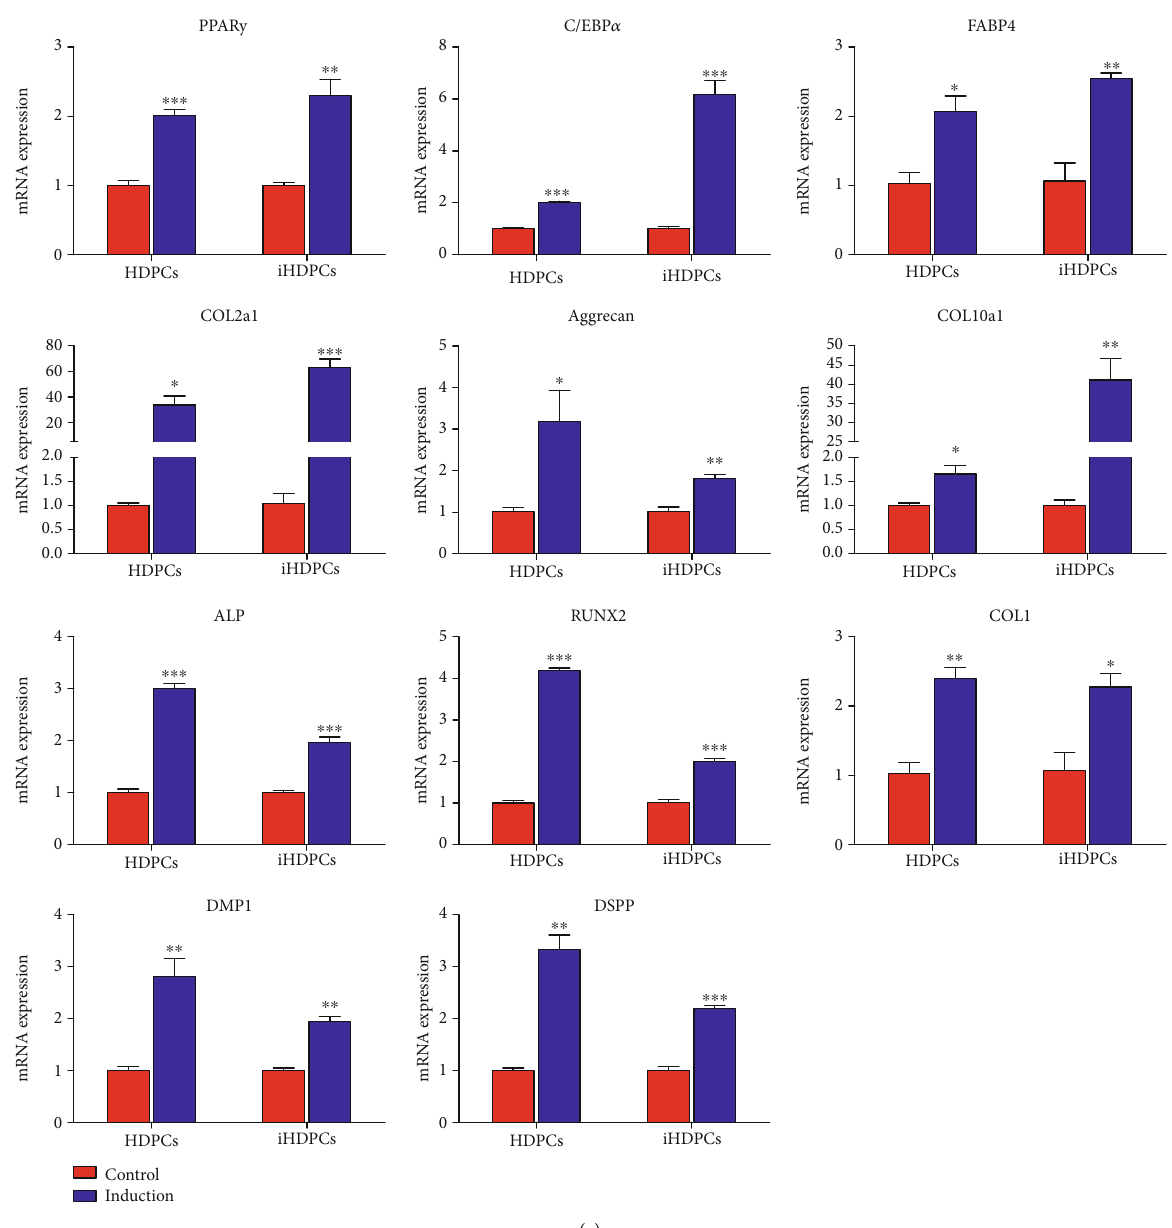
Figure 4: Multilineage di ff erentiation of HDPCs and iHDPCs. (a) Flow cytometric analysis of the antigens expressed by HDPCs and iHDPCs. (b) Percentages of positive cells. (c) Mean fl uorescence intensity of cells stained with the di ff erent antigens. (d) Adipogenic di ff erentiation of HDPCs and iHDPCs determined by Oil Red O staining after culture in adipogenic medium for 14 days. Chondrogenic di ff erentiation of HDPCs and iHDPCs determined by Alcian blue staining after culture in chondrogenic medium for 14 days. Osteogenic/odontogenic di ff erentiation of HDPCs and iHDPCs determined by ALP staining after culture in osteogenic medium for 5 days. (e) qRT-PCR analysis of PPAR γ , C/EBP α , EABP4, collagen 2a1, aggrecan, collagen 10a1, ALP, RUNX2, COL1, DMP1, and DSPP expression ( ∗ P < 0 : 05 , ∗∗ P < 0 : 01 , and ∗∗∗ P < 0 : 001